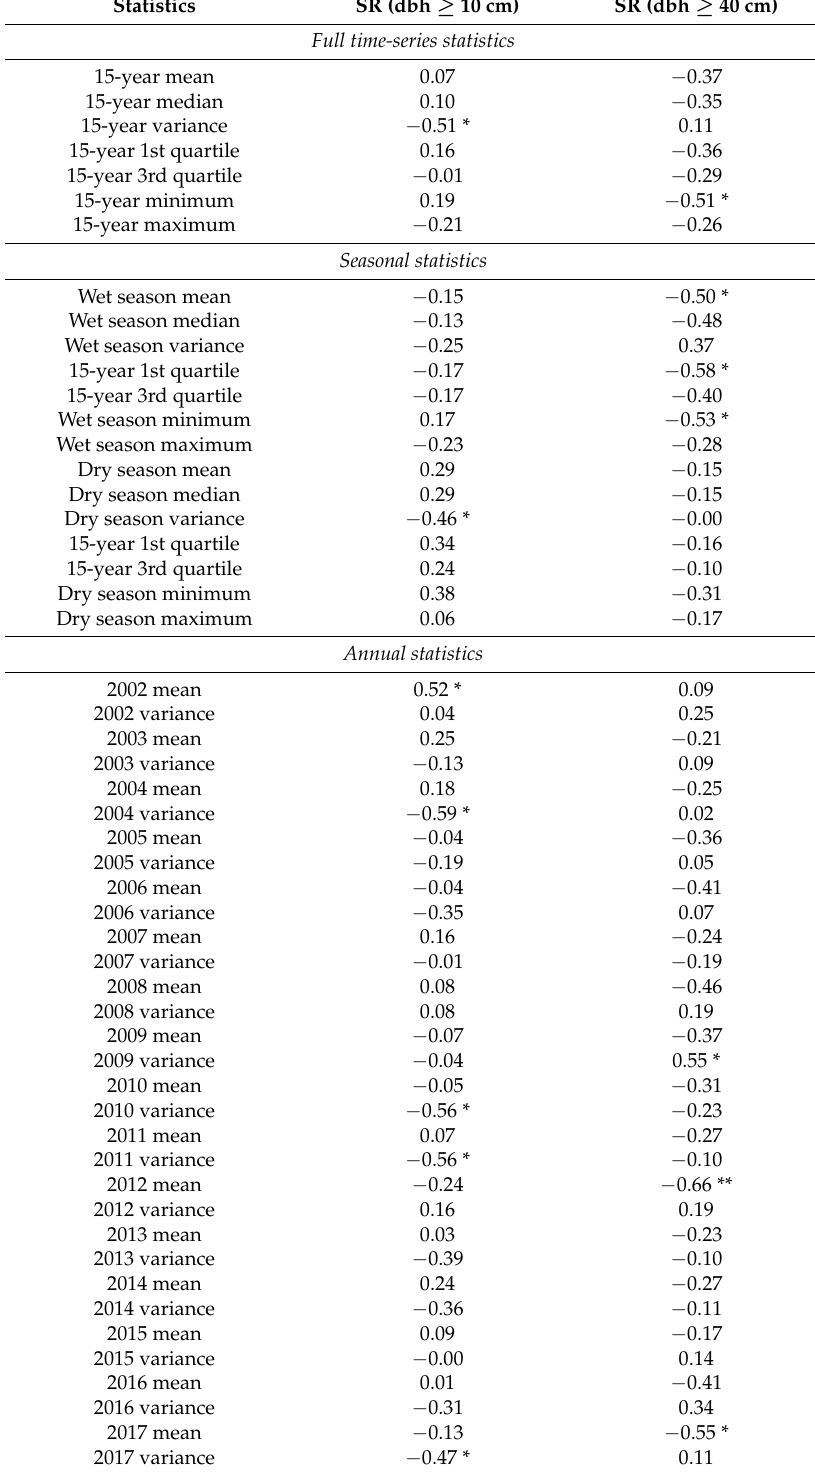
Table A1. Correlation between basic descriptive statistics extracted from a 15-year time series of MODIS EVI images produced on six-day intervals and species richness (SR) measured in 19 one hectare plots in New Caledonia. Asterisks refer to the level of significance: 0.05 < p < 0.01 (*); 0.01 < p < 0.001 (**); p < 0.001